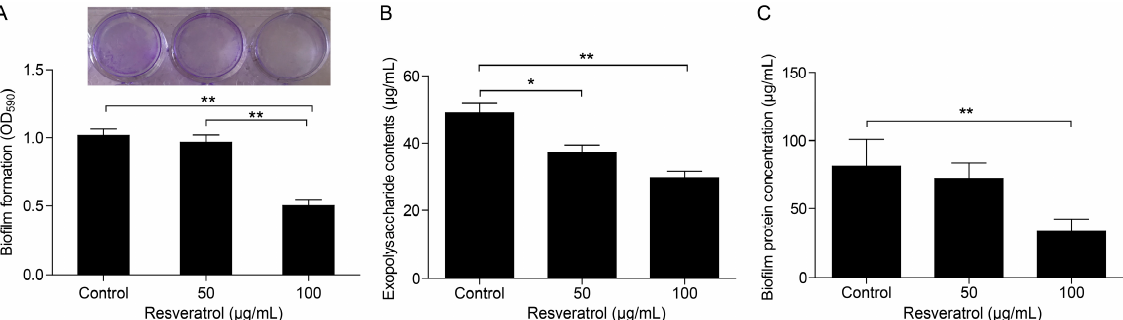
Figure 1. Inhibitory effects of resveratrol on biofilm formation of A. hydrophila NJ-35. ( A ) Crystal violet staining assay. ( B ) Exopolysaccharide production of formed biofilm. ( C ) The total protein of biofilm. The data were presented as the mean ± SD (n = 3) of three independent experiments. * p < 0.05, ** p < 0.01.